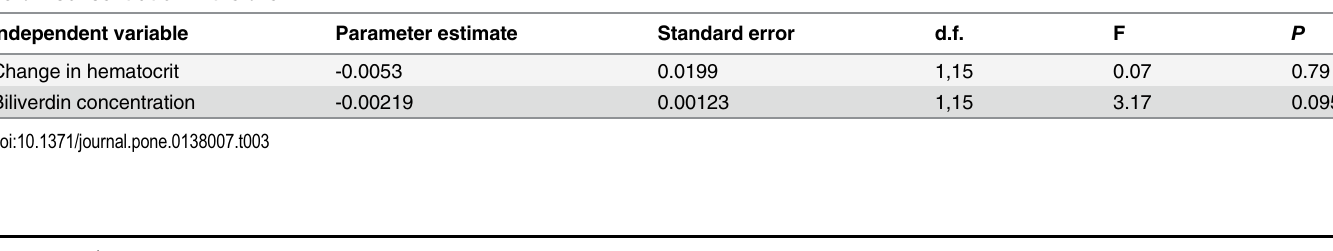
Signi fi cant relationships ( P < 0.05) are indicated in bold type.